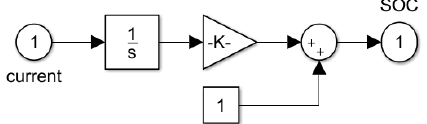
Figure 7. The internal structure of ampere-hour (AH) integral.